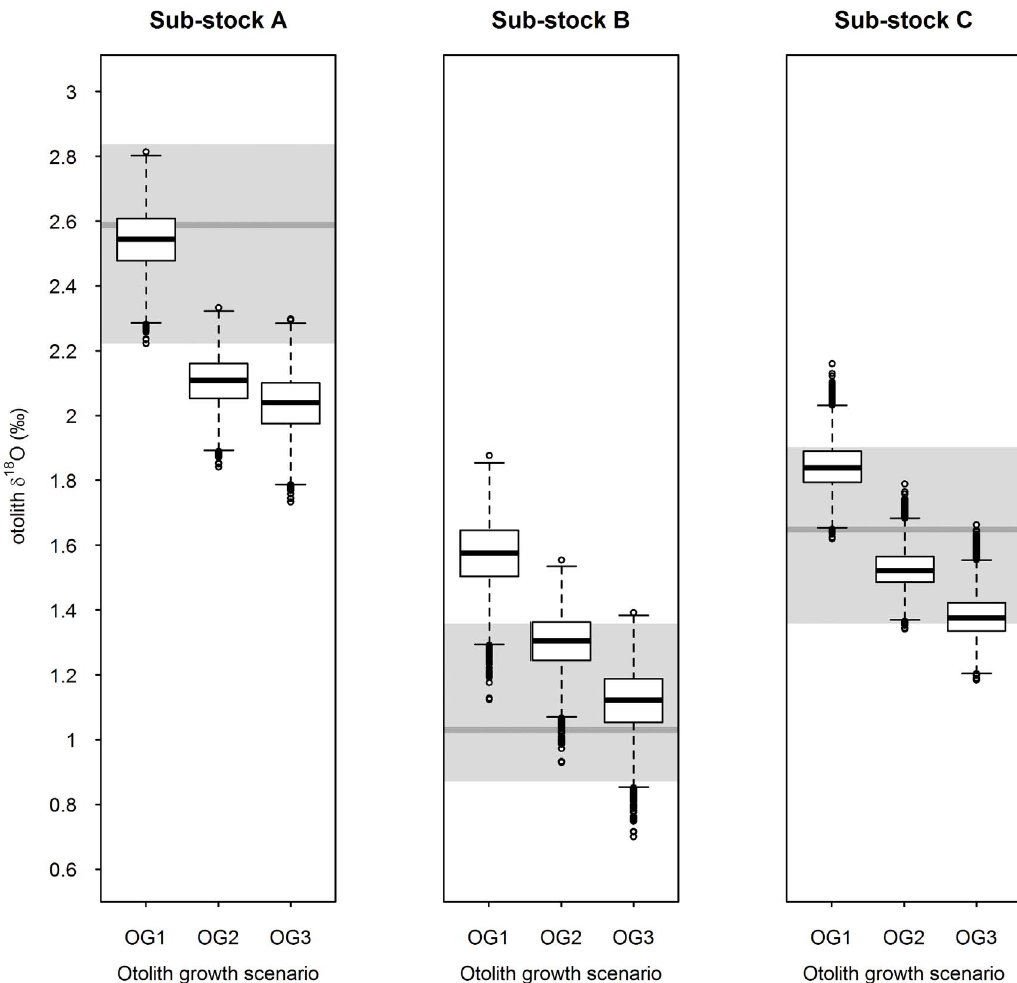
Figure 4. Annual otolith d 18 O predictions per growth scenario for the 3 sub-stocks. Predicted annual d 18 O values (in white) were obtained by individually applying each of the 3 plausible otolith growth scenarios (OG1, OG2 and OG3) to monthly d 18 O derived from the stock-specific temperature and salinity conditions experienced (10,000 simulations per scenario and sub-stock). In each case, the white box includes 50% of the data and the whiskers 99%, with the bold line within the box indicating the median and the circles the outlier values. For comparison, the full range of observed annual d 18 O values is represented for each sub-stock (in grey, the bold line indicating the median).